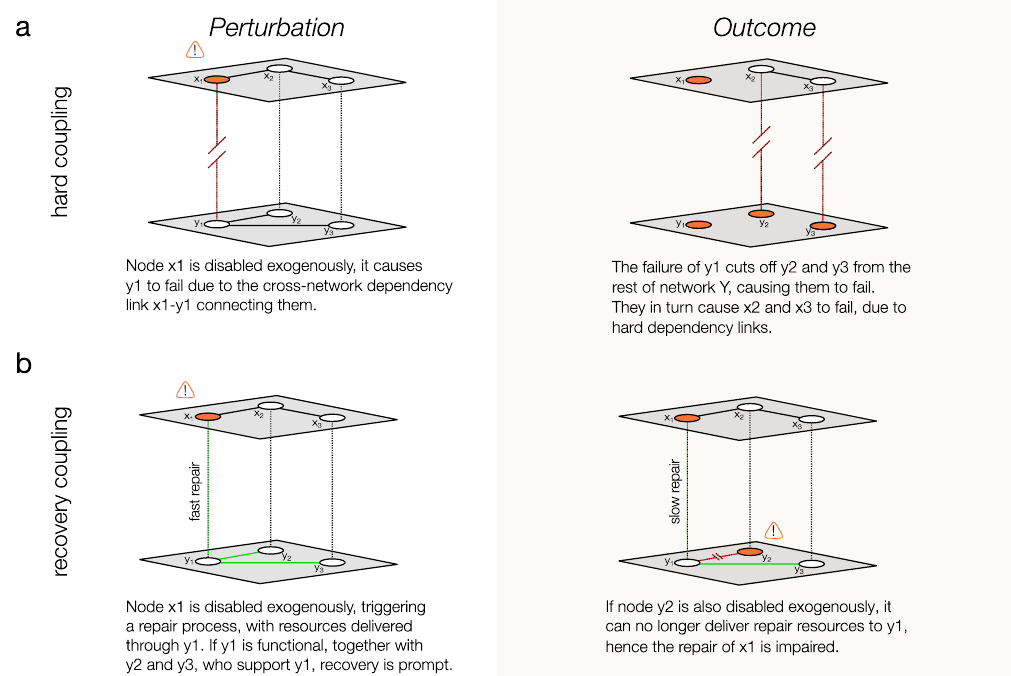
Fig. 1 Damage and recovery in interdependent networks. a Under the hard coupling model, when node x 1 fails, it causes a cascade across both networks that disables the entire system. b With recovery coupling on the same network, when node x 1 fails it is repaired using resources from network Y delivered through node y 1 . Failures in network Y will impair that repair